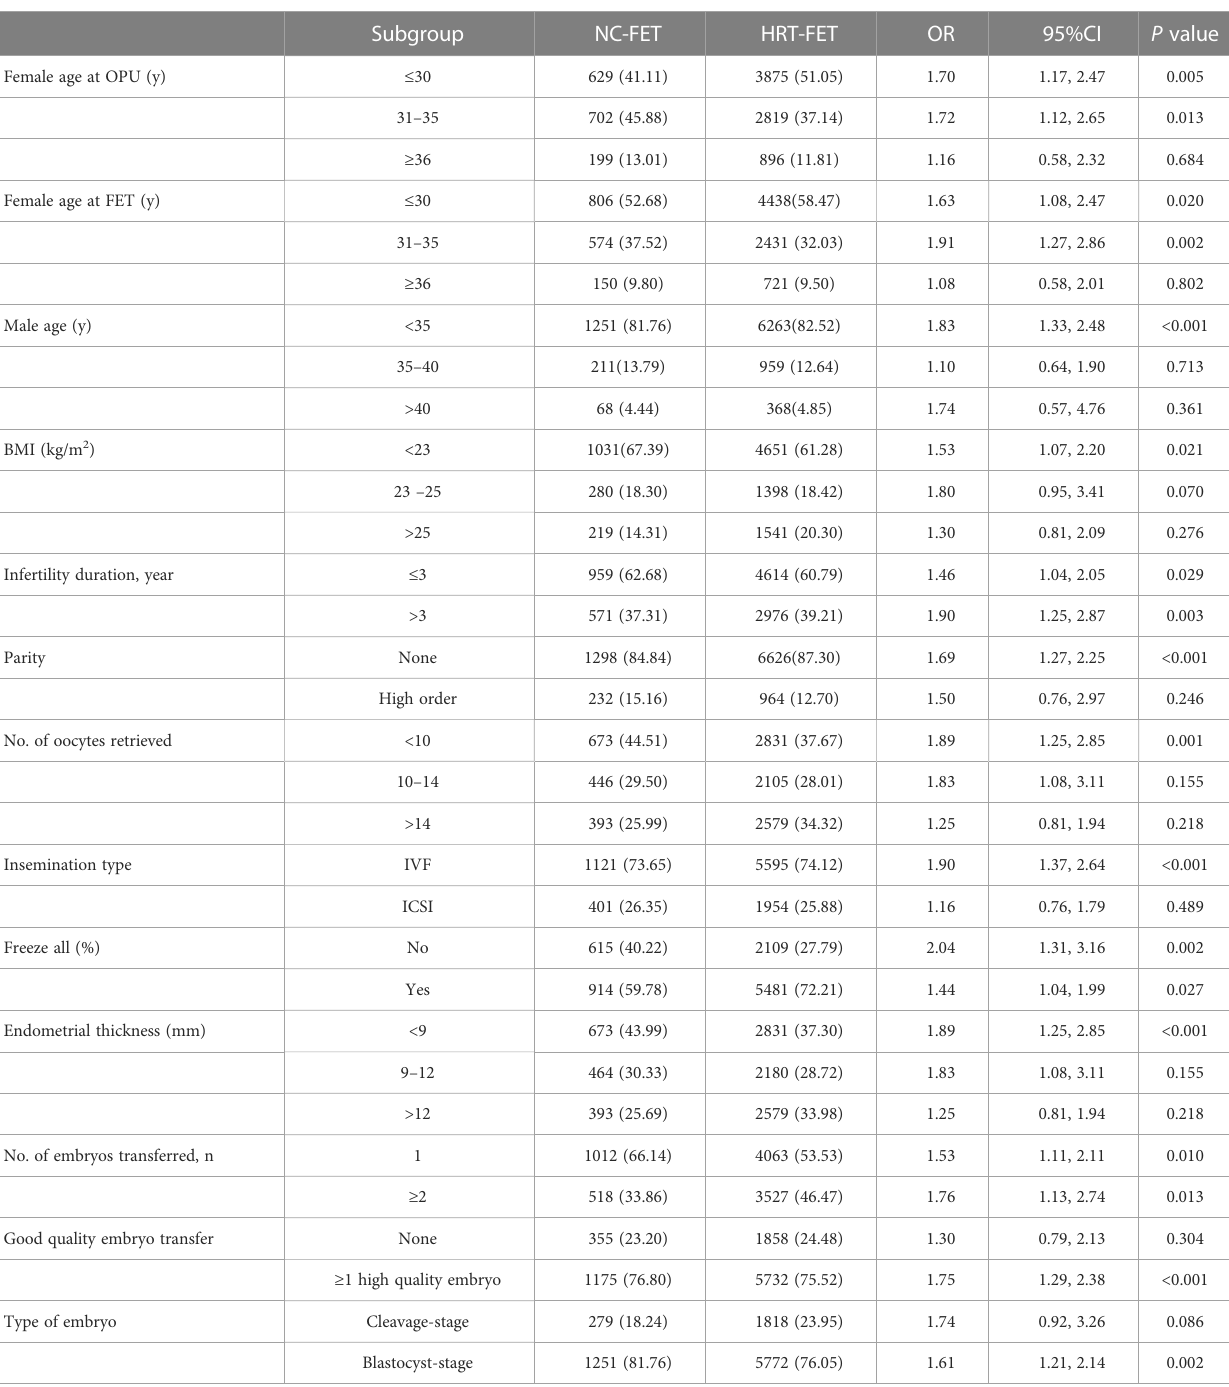
TABLE 4 Subgroup analysis of different FET regimens on